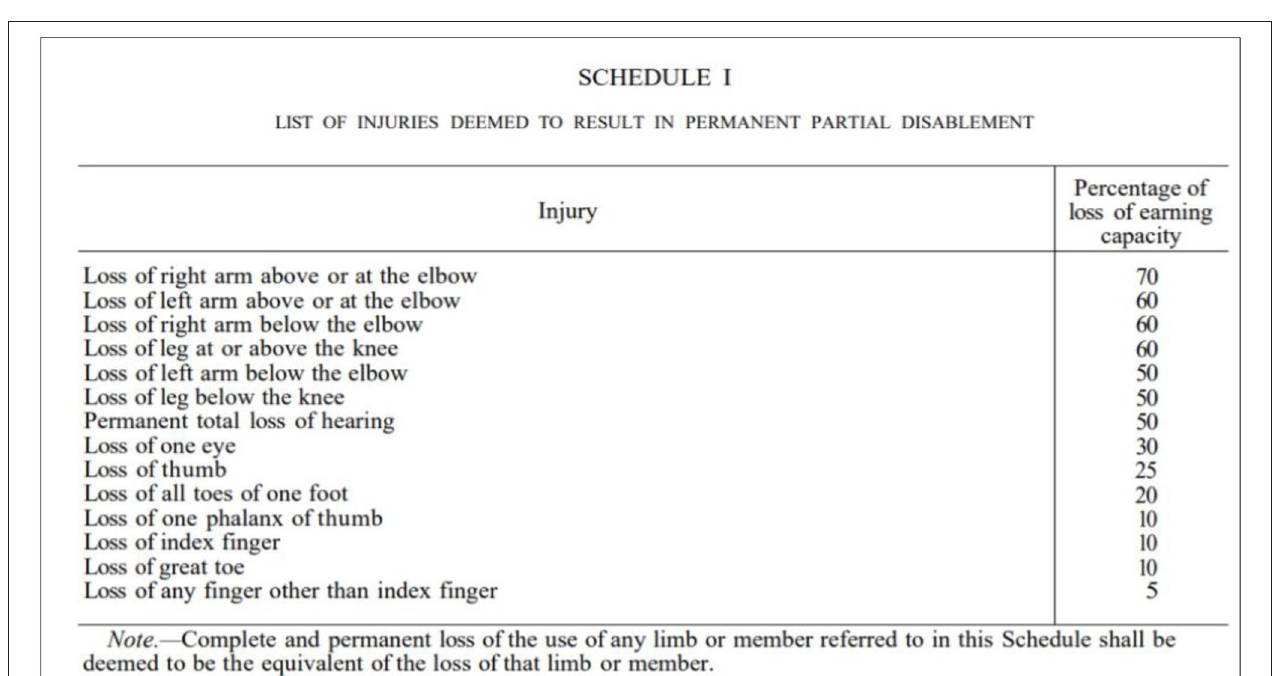
FIGURE 1 | List of injuries deemed to result in permanent/partial disablement in the Workmen’s Compensation Ordinance No. 19 of